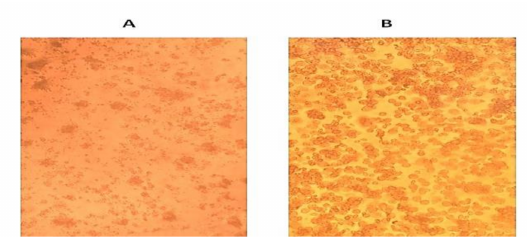
Figure 3. Viral inoculation onto duck embryo liver (DEL) cell culture: ( A ) Infected cells showing detachment and clumping, ( B ) non-infected DEL cell monolayer (negative control).